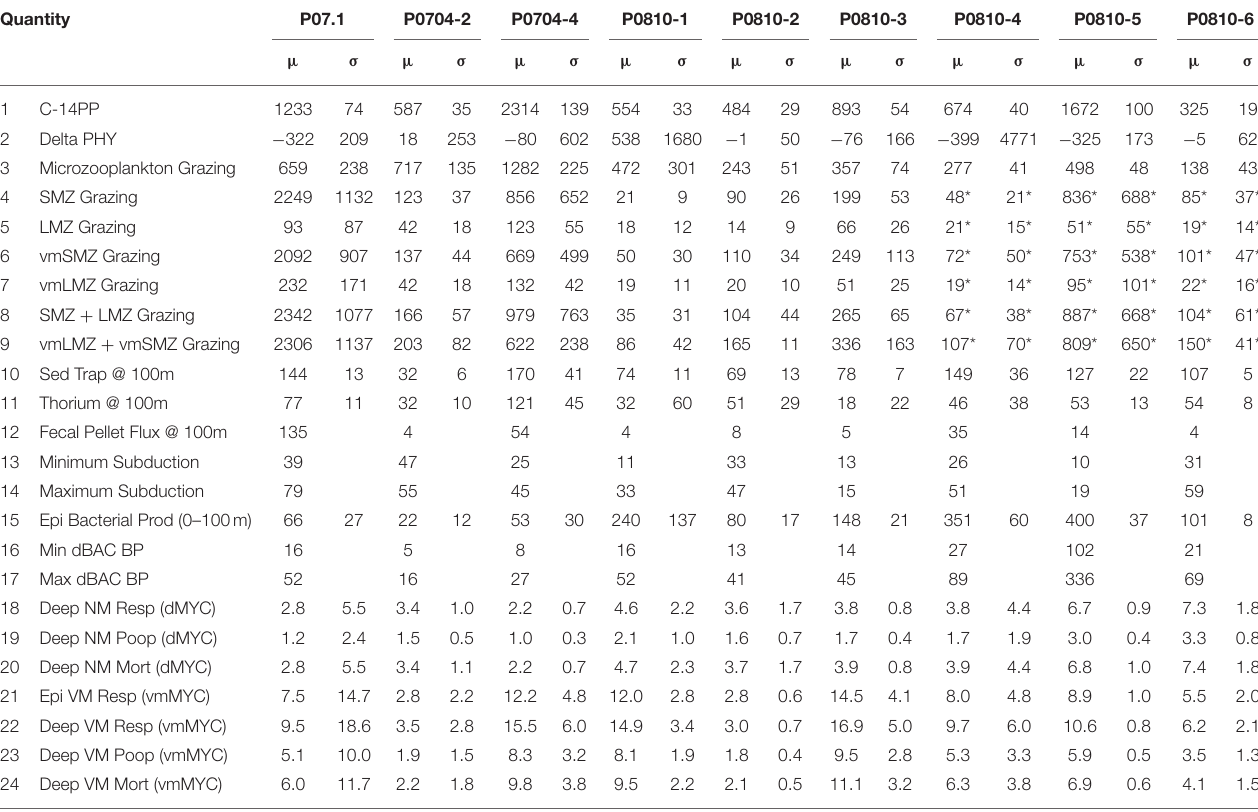
Values given show the mean ( µ ) and 1 SD ( σ ) for each cycle except for min/max constraints which are blank. Marked values ( * ) were assumed values calculated from cycles of the same classification (see section Mesozooplankton and Nekton Constraints). All values are given in mg C m − 2 d − 1 .